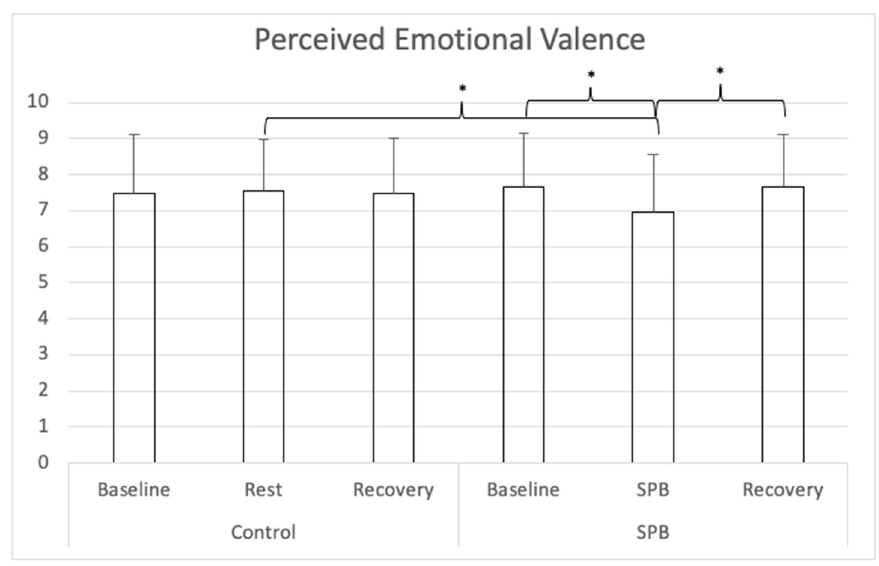
Figure 4. Perceived Emotional Valence. Note: SPB: Slow-paced breathing; * p < 0.006 (Bonferroni correction).